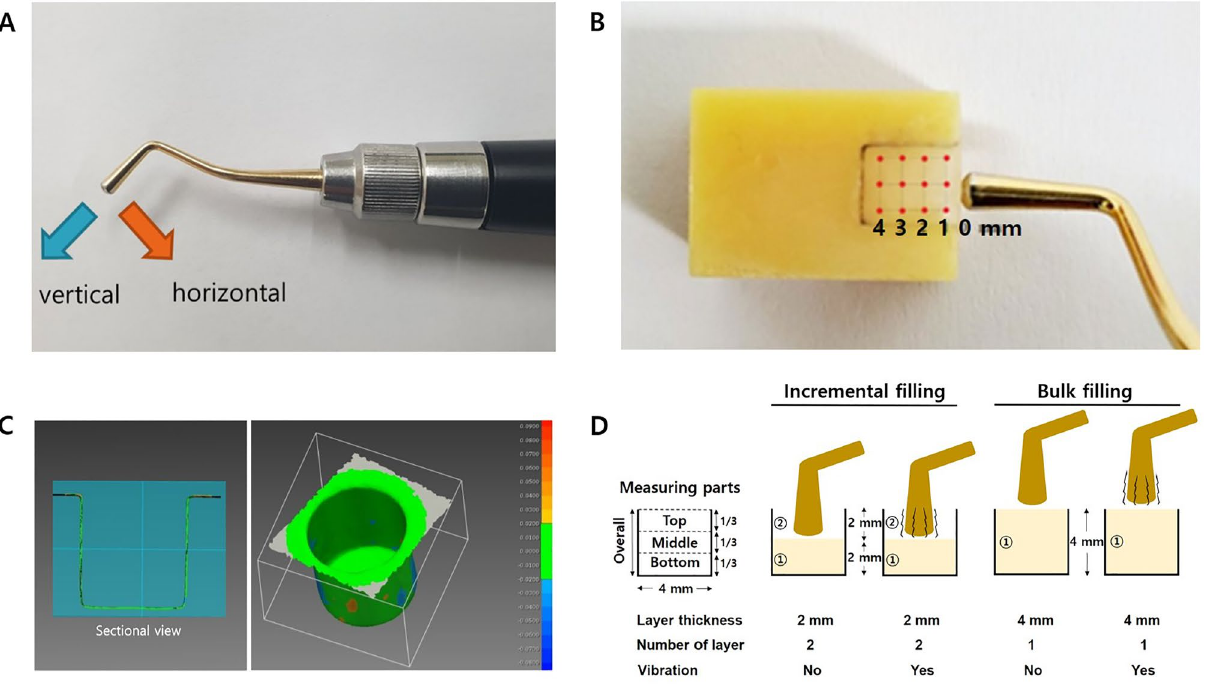
Figure 1. Experimental set-up. ( A ) Vibratory resin applicator with a rounded-end tip. The vibration frequency of device was measured vertically and horizontally to the tip. ( B ) Measurement points 1-mm apart placed on the resin surface using SLDV software 16 . ( C ) Representative deviation colour map of milled cylindrical cavities. Green indicates a value equal to or less than a deviation of ± 20 µm. ( D ) Study group for evaluation of composite resin adaptation to the